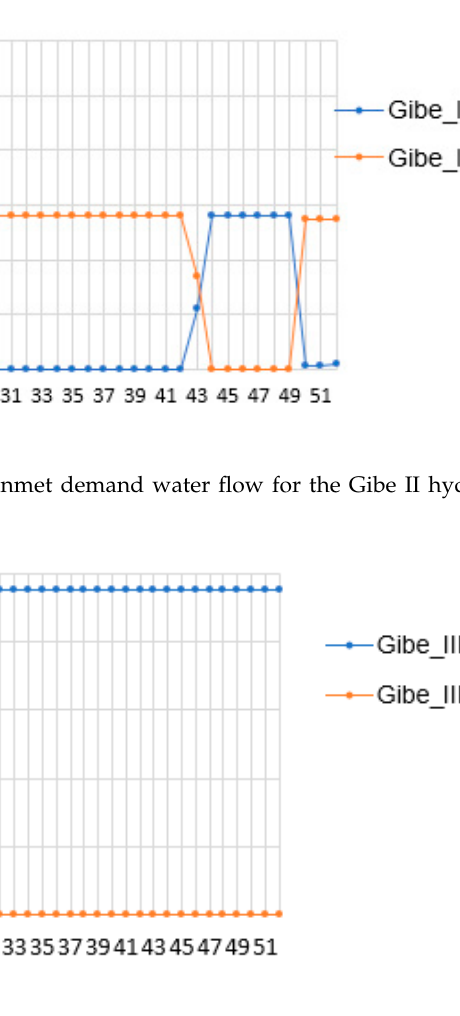
Figure 23. Water allocation and unmet demand water flow for the Gibe I hydropower station (Mm 3 /week).